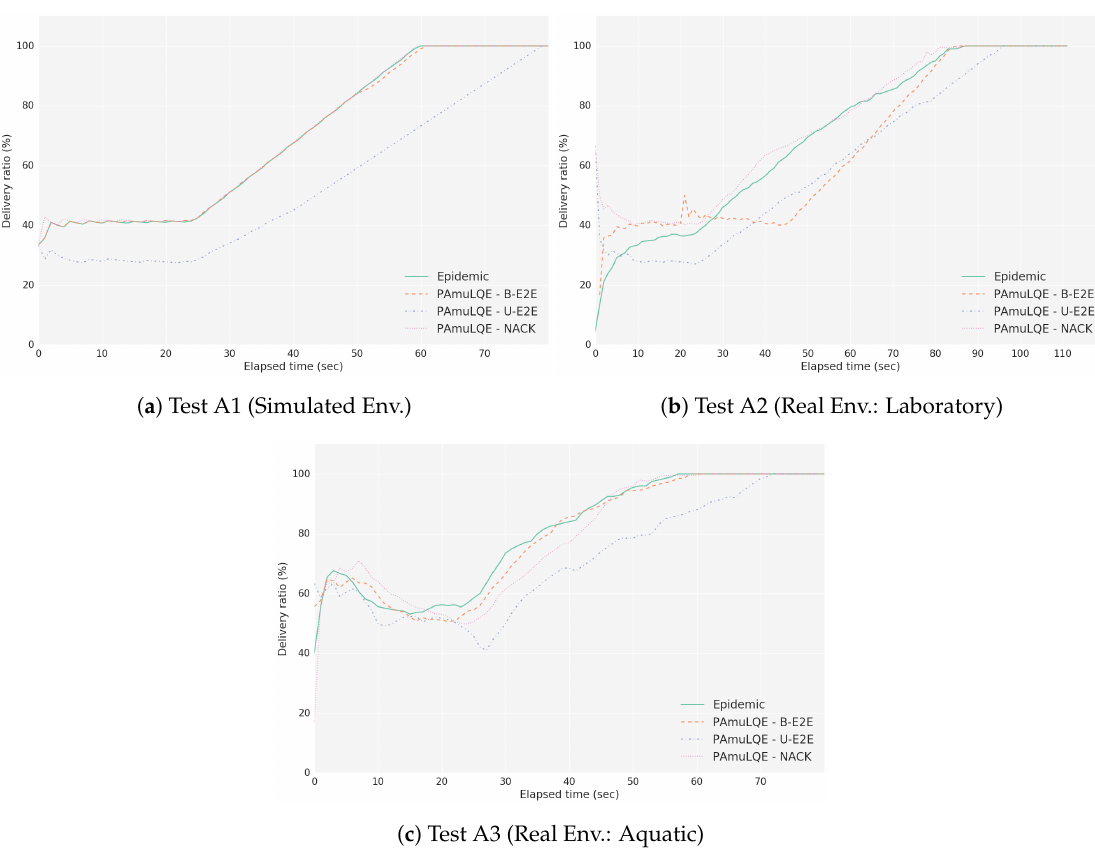
Figure 21. Delivery Ratio for Scenario A. The plots represent the ratio between the delivered data packets to a gateway and the overall data